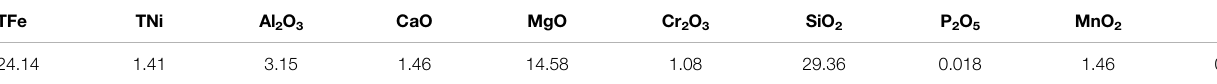
TABLE 1 | Main chemical composition of nickel laterite ore (wt%).